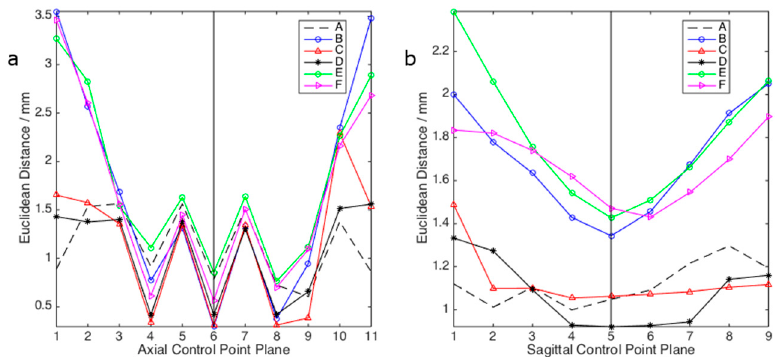
Figure 5. Mean Euclidean distance in mm for the axial ( a ) and sagittal ( b ) control point planes of the phantom. The vertical line in each figure represents the central control point plane in both orientations.